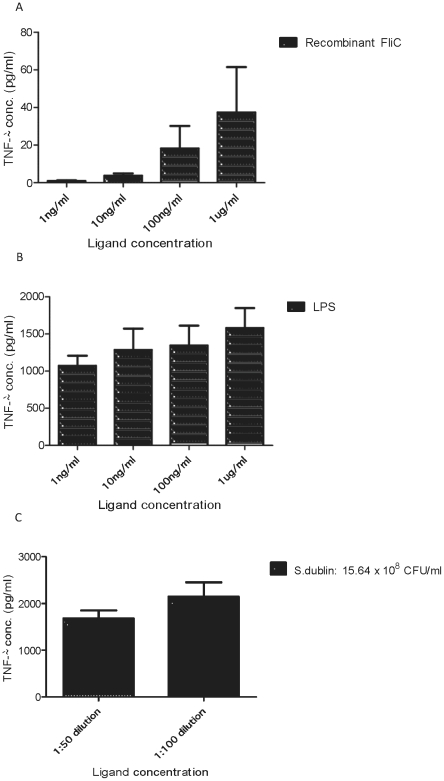
Activation of TNFα secretion in whole blood stimulation assays with flagellin, LPS or Salmonella dublin.Whole blood was diluted with twice the volume of RPMI and stimulated with flagellin, LPS or heat-inactivated Salmonella dublin at different concentrations for 24 hours before production of TNFα was analysed by an ELISA. The results displayed are the mean values obtained from four healthy blood donor dogs (2 Labradors, 1 Greyhound and 1 Great Dane) each with two repeats under the same conditions, with error bars illustrating standard error of the mean.